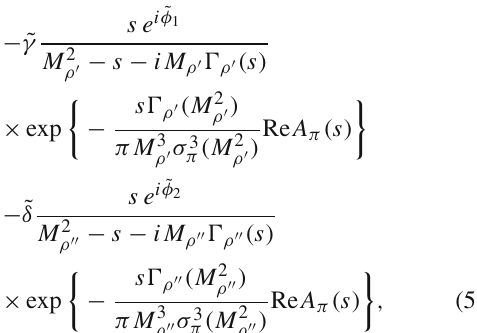
= 4 GeV 2 in the cut